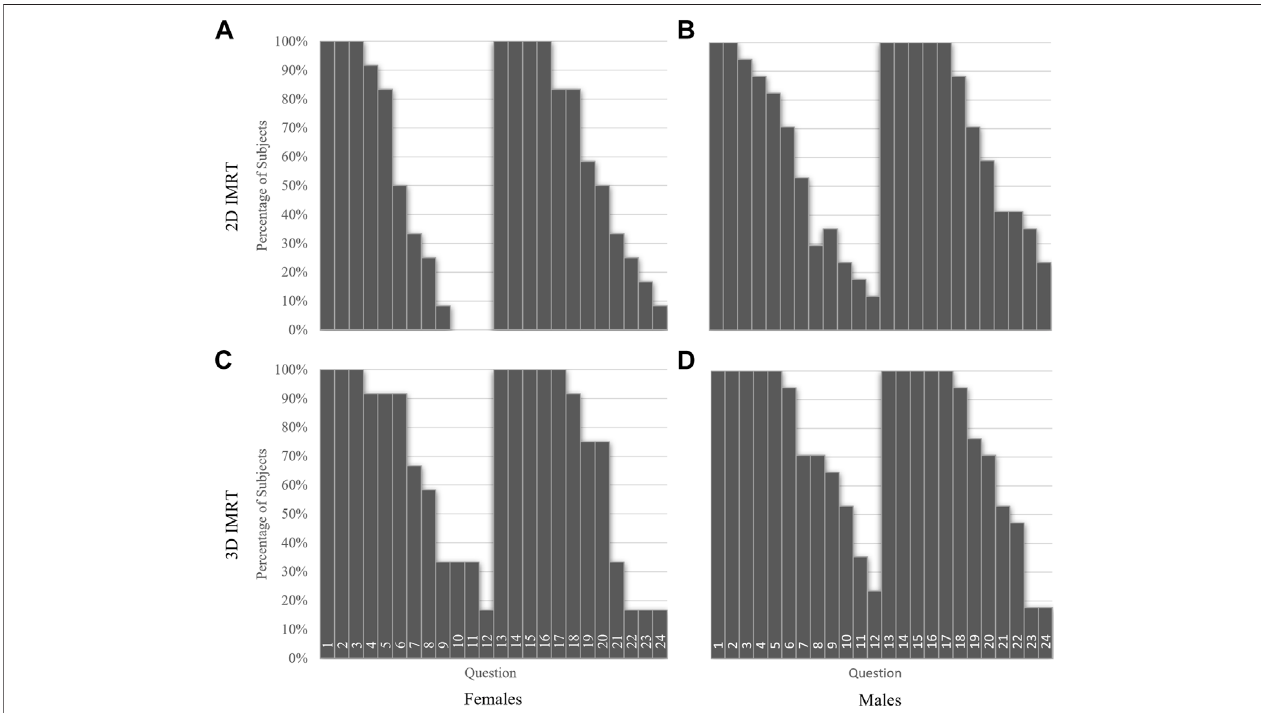
FIGURE 8 | The percent of participants answering a question as a function of question order. 2D IMRT scores are presented for females (A) and males (B) and 3D IMRT scores are presented for females (C) and males (D) .